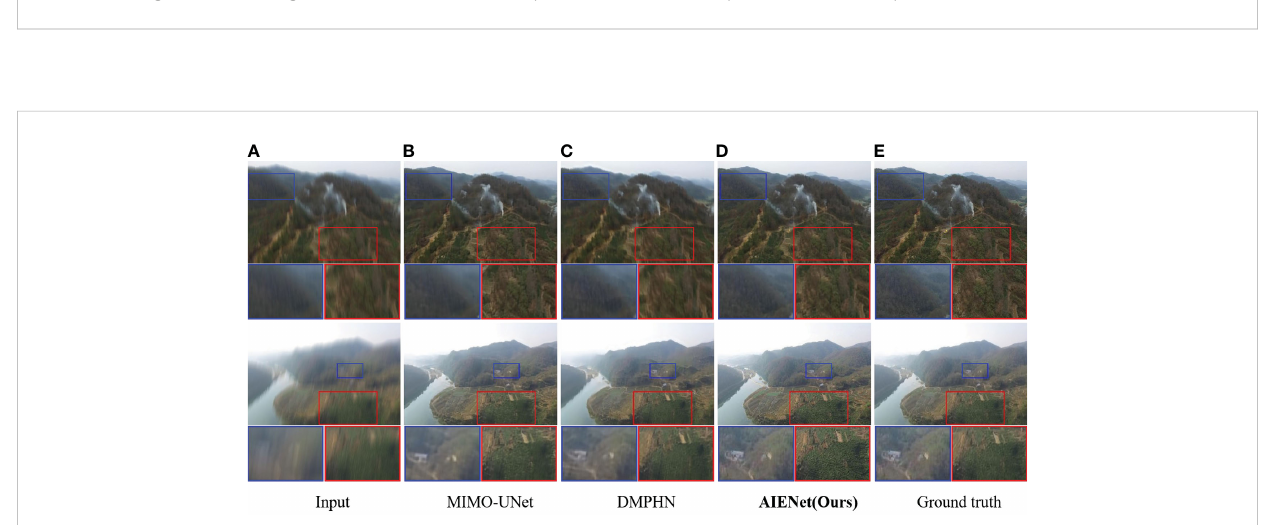
FIGURE 5 Qualitative enhancement comparisons of our model on synthetic hazy samples with FFANet (Qin et al., 2020) and GCANet (Ren et al., 2018). (A) is the input hazy images, (B, C) are the enhancement results of the state-of-the-art algorithms, (D) is the enhancement results of the proposed AIENet, and (E) is the ground truth images. Blue and red boxes correspond to the zoomed-in patch for better comparison.